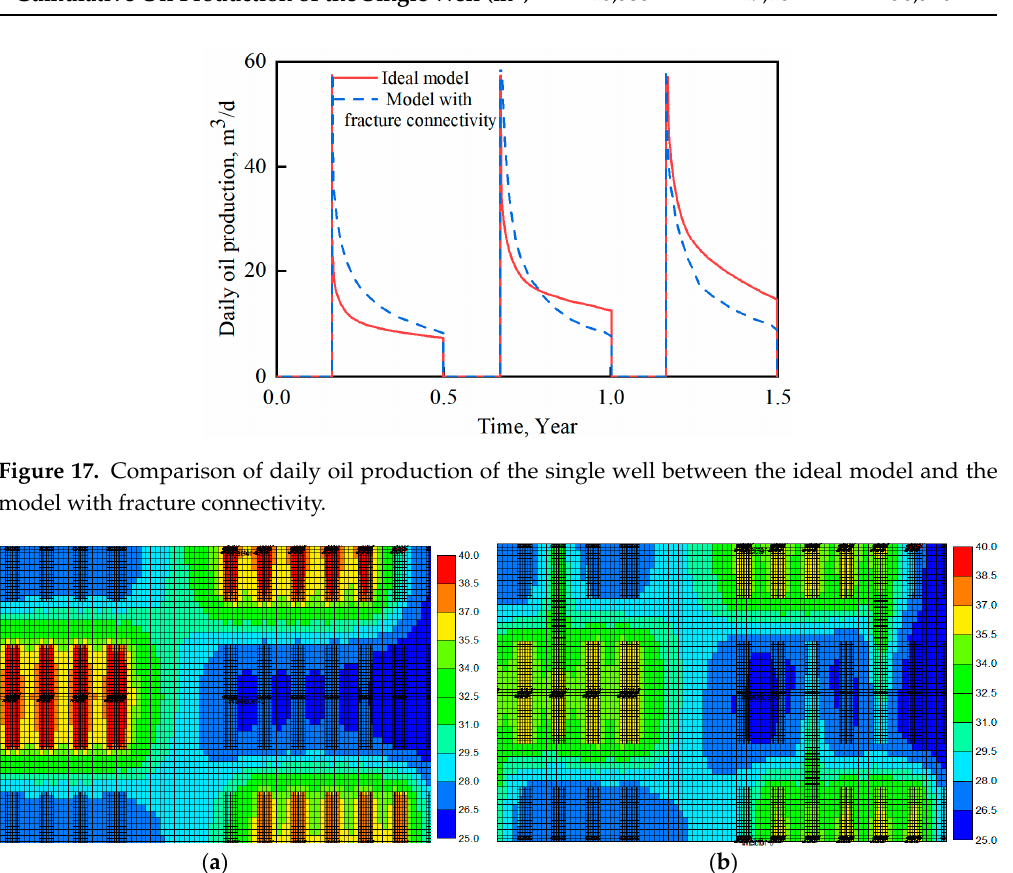
Figure 18. Comparison of formation pressure at the end of gas injection period between the ideal model and the model with fracture connectivity (unit: MPa). ( a ) Ideal model; ( b ) model with fracture connectivity.